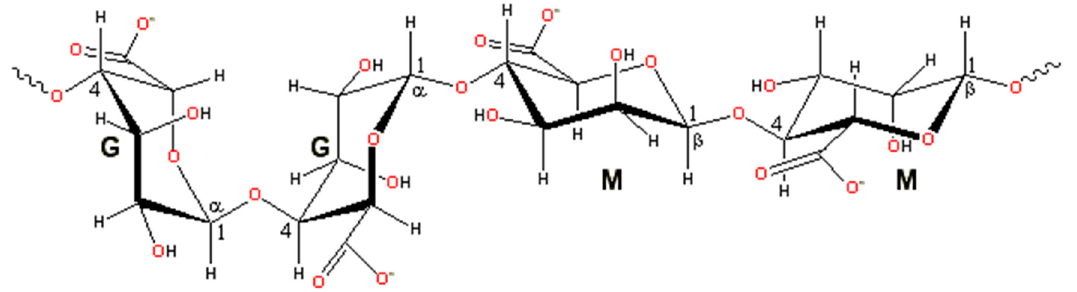
Figure 1. Structure units of alginate molecule (from Wikipedia, the free encyclopedia).